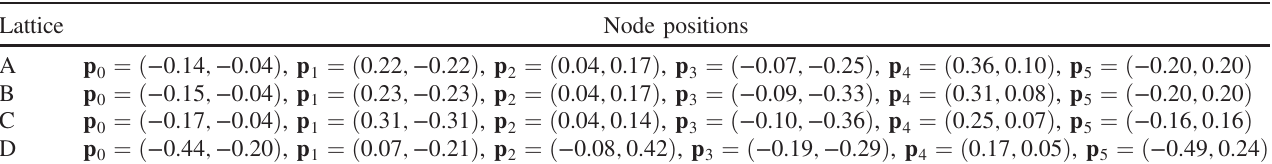
TABLE II. Unit cell descriptions of distorted hexachiral lattices. Labels A – C refer to the lattices in Fig. 3, and label D is the lattice used in Fig. 4. The position of the nodes [labeled in Fig. 5(b)] is specified in units of the lattice constant a ; the primitive vectors and link connectivity are